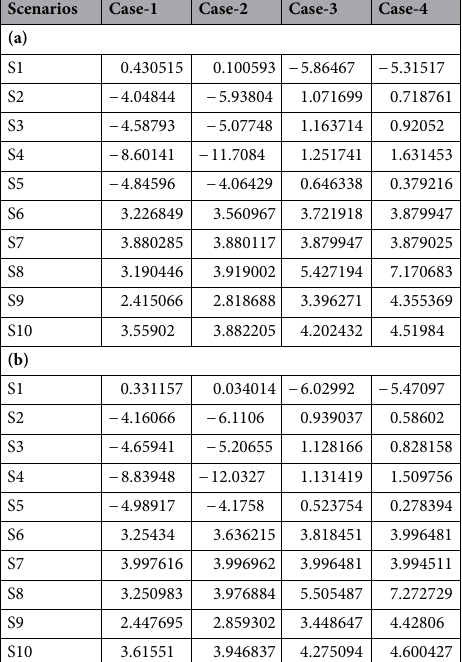
Table 7. Nusselt numbers evaluated during different scenario and cases for (a) Copper nanoparticles, (b) Silver nanoparticles.